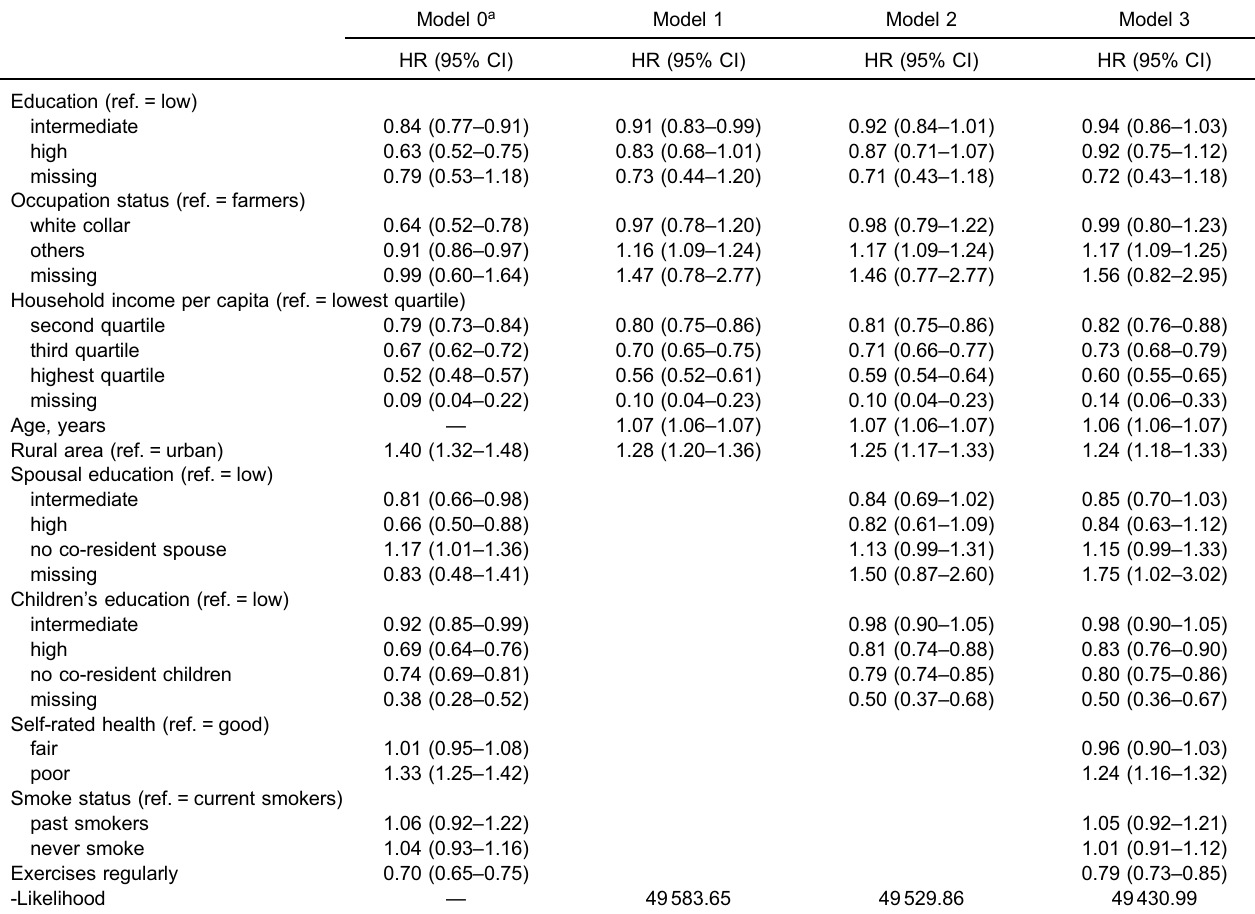
Table 3. Hazard ratios and 95% con fi dence intervals from Cox proportional model for females ( n = 15008)